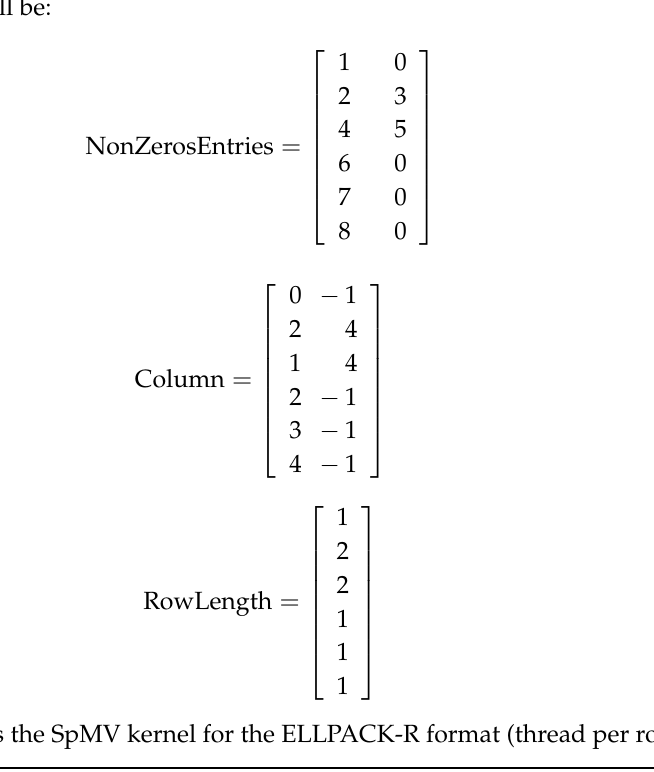
Algorithm 3 The SpMV kernel for the ELLPACK-R format (thread per